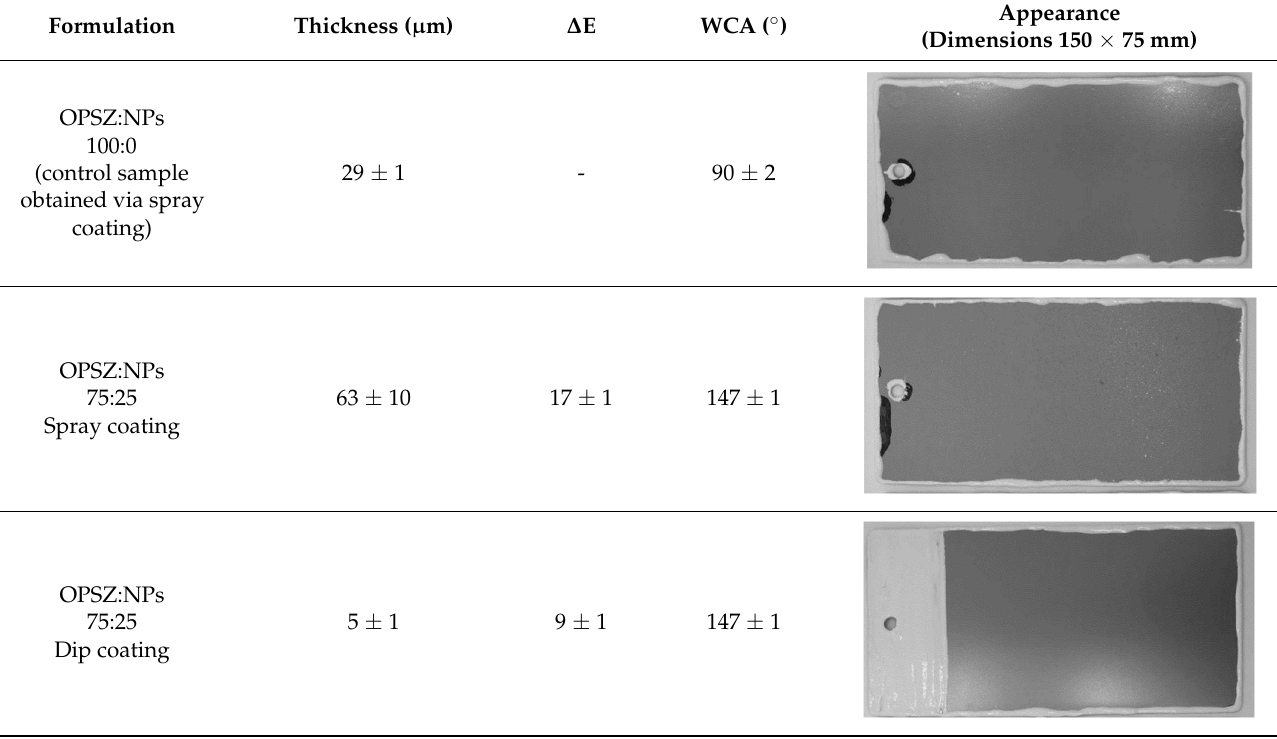
Table 1. Main characteristics of the studied coatings.